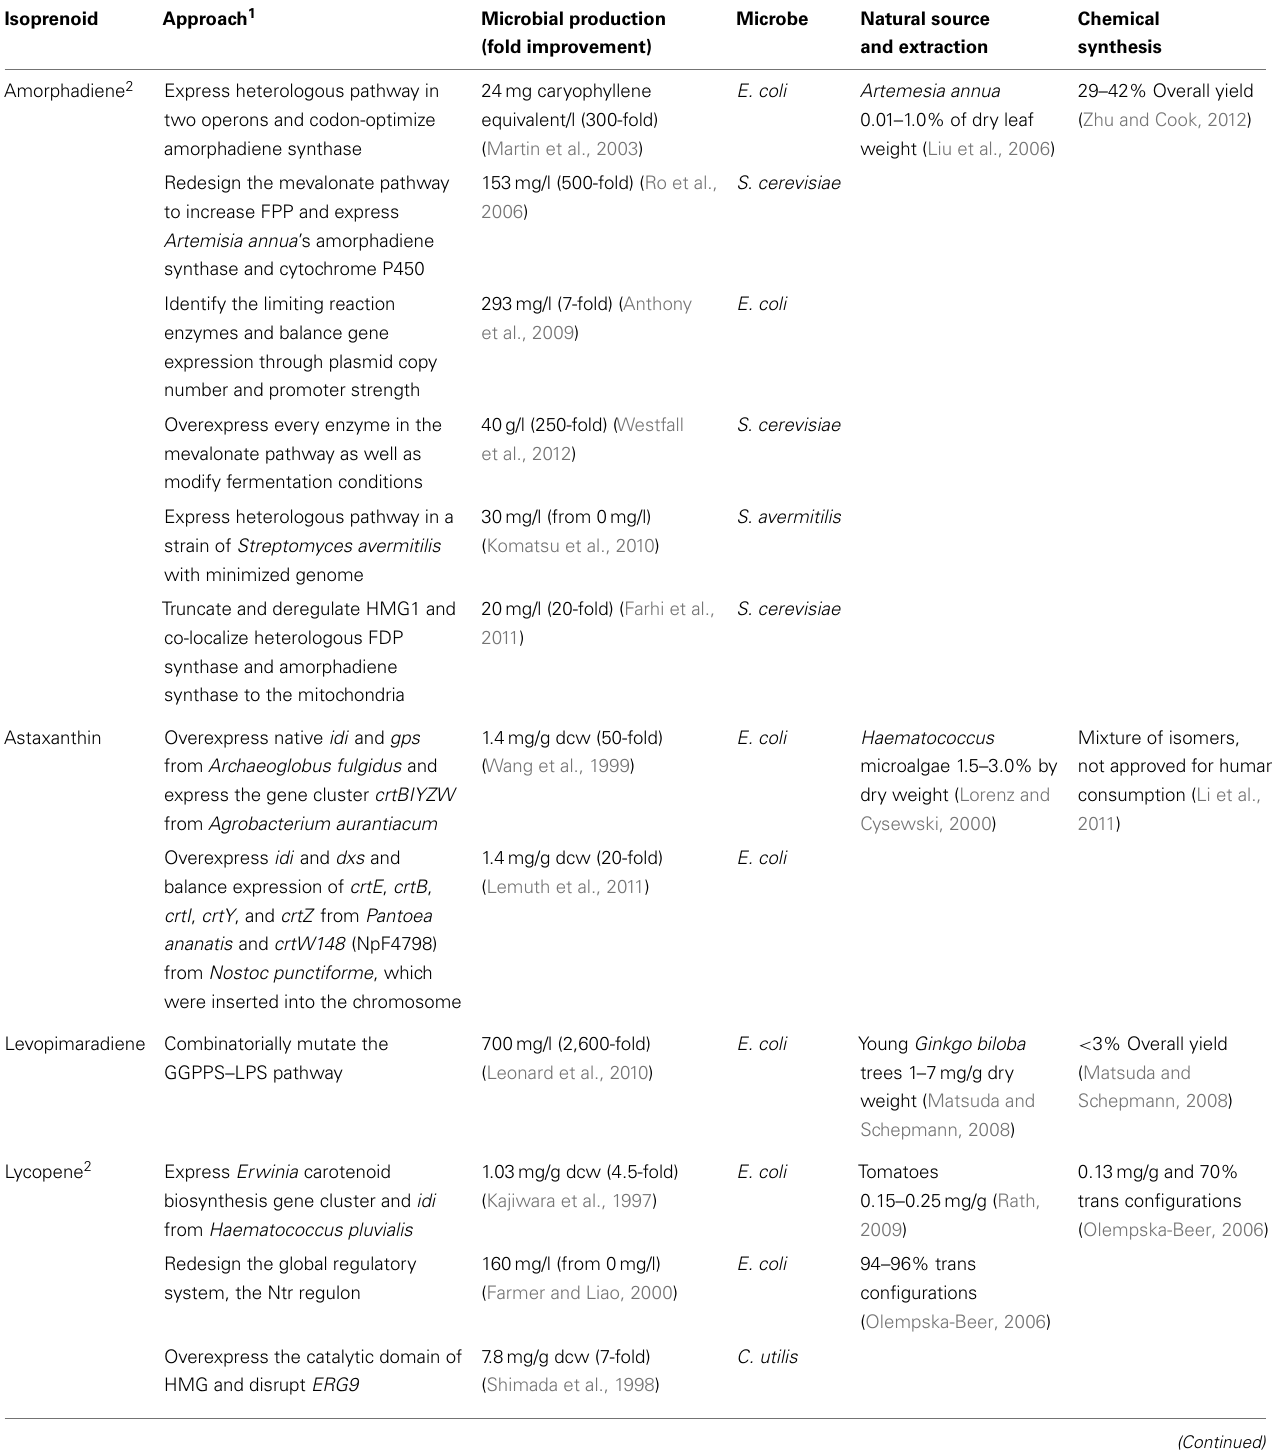
Table 1 | Isoprenoid